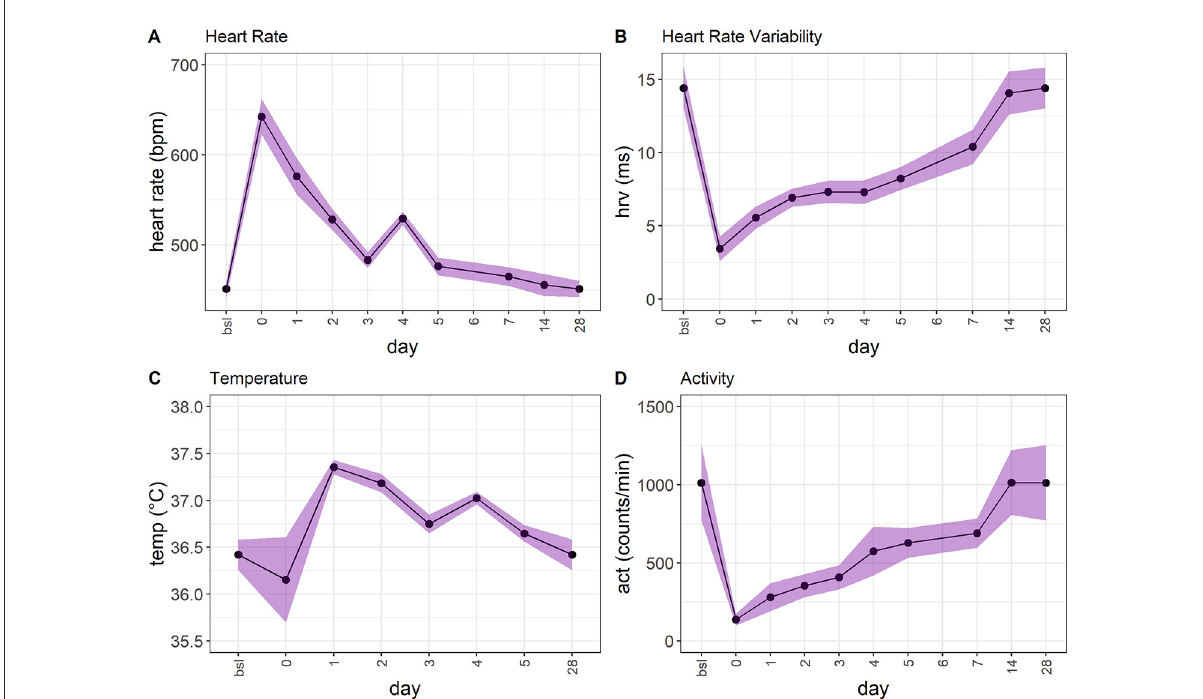
FIGURE3 (A) The heart rate (hr) in TM-implanted female C57BL6/J mice ( n = 13) shows an increase on surgery day and returns back to baseline levels. However, the recovery is much slower than, e.g., in burOn and bwc. (B) The heart rate variability (hrv) shows a similar development to hr. The maximum drop occurs after surgery (day 0). After that, the animals recover over 28 days. (C) The temperature shows an ambiguous development. There is a slight drop after surgery, followed by an increase that slowly returns to baseline levels. However, the range of the temperature variable is small ([34.10; 37.52] ◦ C). (D) The activity (act) variable shows a drop after surgery (day 0) and returns back to baseline levels over the next 14